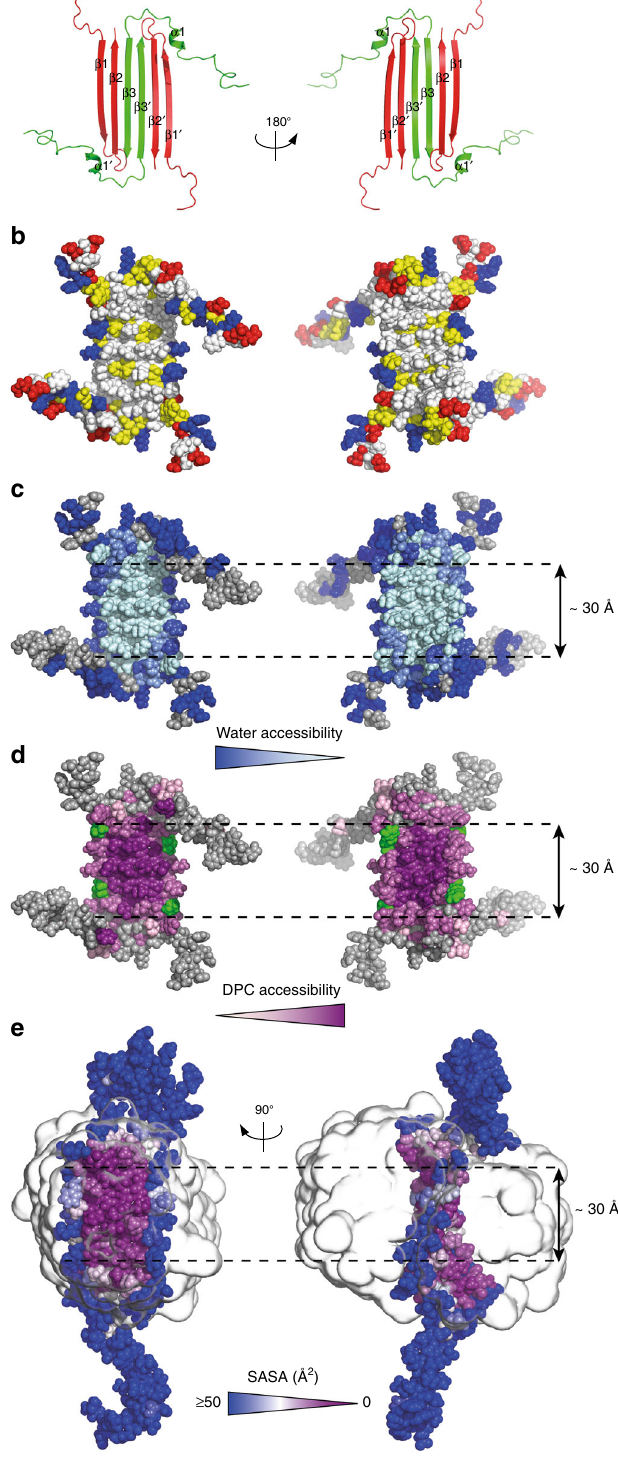
Fig. 2 3D structure of the A β (1-42) tetramer prepared in DPC. a Ribbon diagram of the A β (1-42) tetramer structure. A β (1-42) subunits are colored either red or green to identify the asymmetric dimer unit that constitutes the building block of the A β (1-42) tetramer. b Distribution of hydrophobic and charged residues on the surface of the A β (1-42) tetramer. Hydrophobic residues are white, polar are yellow, and positively and negatively charged are red and blue, respectively. c Water accessibility of amide protons revealed through 2D [ 1 H, 15 N]-HSQC spectra obtained at different pHs and through measurement of amide temperature coef fi cients. Solvent accessibility is linearly coded on the basis of the intensity of blue, with light blue corresponding to low water accessibility and dark blue corresponding to high water accessibility. Unassigned residues are shown in gray. d DPC accessibility of amide protons. The residues that showed NOEs between the backbone amide proton and the N-bound methyls of the choline head group of DPC are shown in green. The amide residues that showed paramagnetic enhancement, ε , upon addition of 16-DSA are shown in magenta. The ε values are linearly coded on the basis of the intensity of magenta, with light pink corresponding to ε = 0 and dark magenta corresponding to ε = ε max . e Solvent Accessible Surface Area (SASA, Å 2 ) from MD simulations of the A β (1-42) tetramer in DPC. Detergent micelle is represented as a smoothed transparent surface. The fi gure was prepared with the program Pymol. Source data are provided as a Source data fi